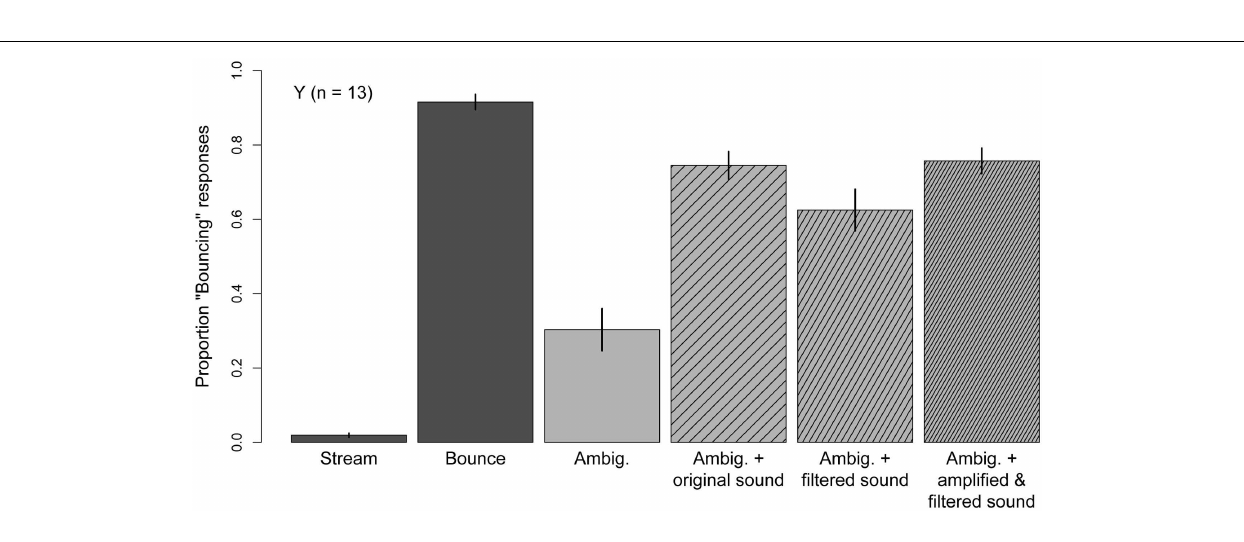
FIGURE 7 | Mean Pr(“Bouncing”) responses produced in each condition of ExperimentThree: stream and Bounce ; Ambiguous ; Ambiguous accompanied by the sound used in Experiments One andTwo; Ambiguous accompanied by a filtered version of the sound used in